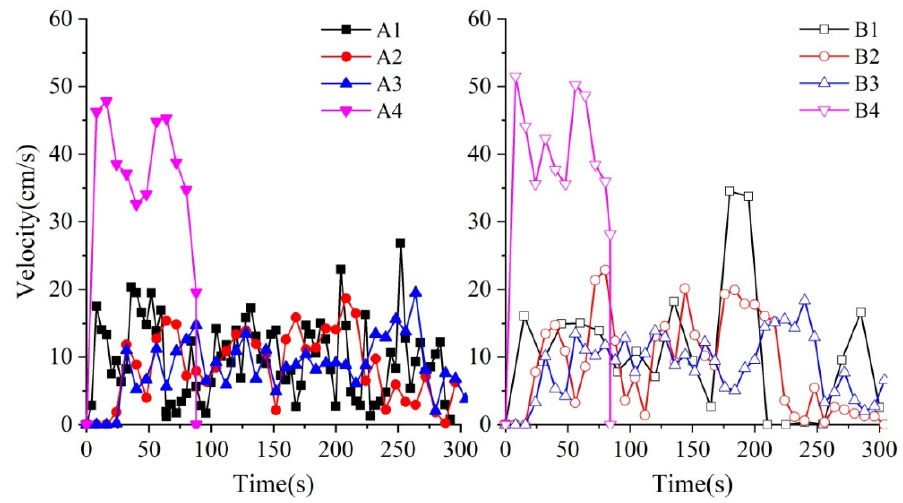
Figure 5. Water flow velocity under different treatments.